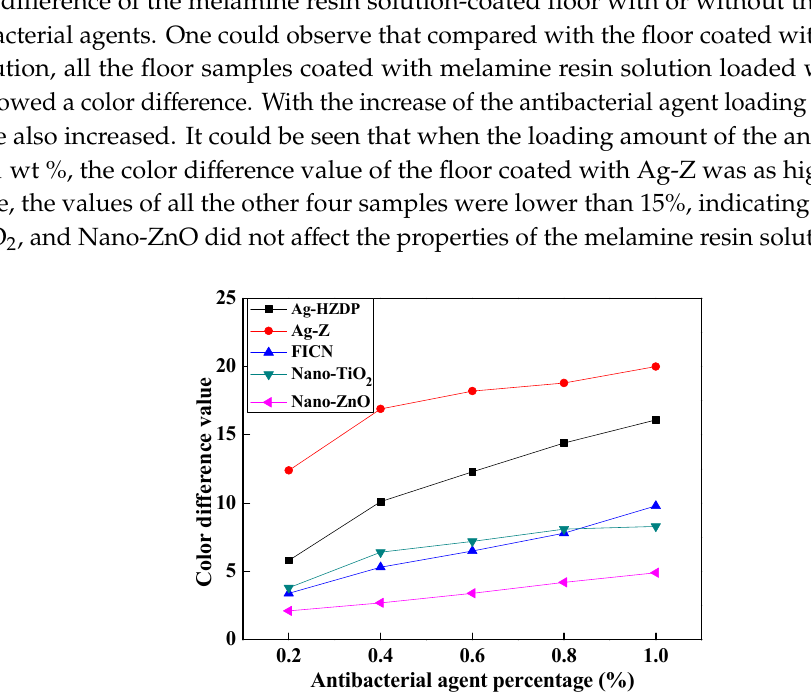
ff ect of di ff erent quantities of antibacterial agents on the color of the Figure 1. Effect of different quantities of antibacterial agents on the color of the coatings . Figure 1. E